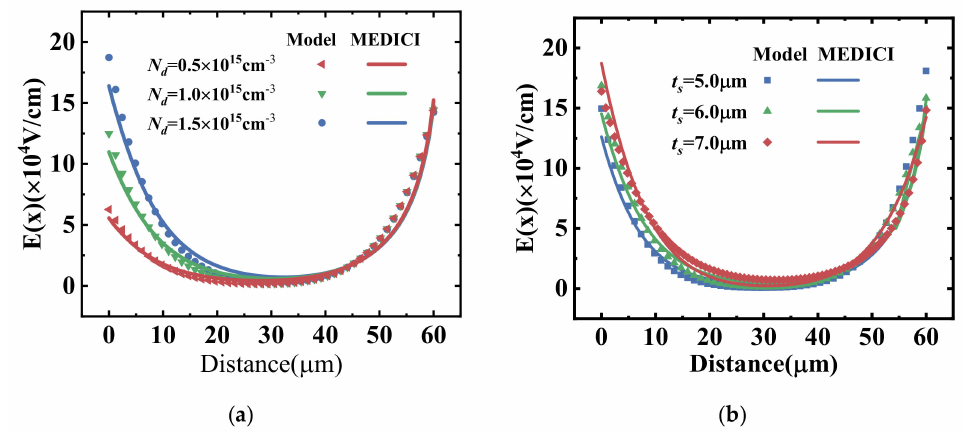
Figure 2. Modeled and simulated surface electric field profile of the SOI S − RESURF lateral power devices with ( a ) the doping concentration of the drift region and ( b ) thickness of the epitaxial layer.